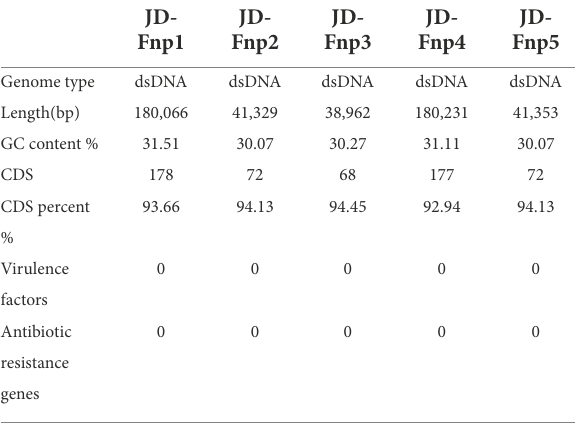
TABLE 2 Genomic information of JD-Fnp1 ~ JD-Fnp5.